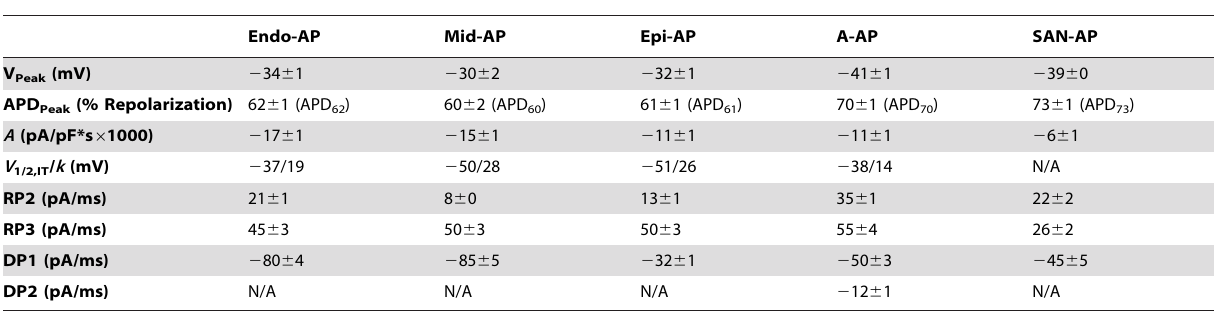
Table 2. Characteristics of I HERG Reported by